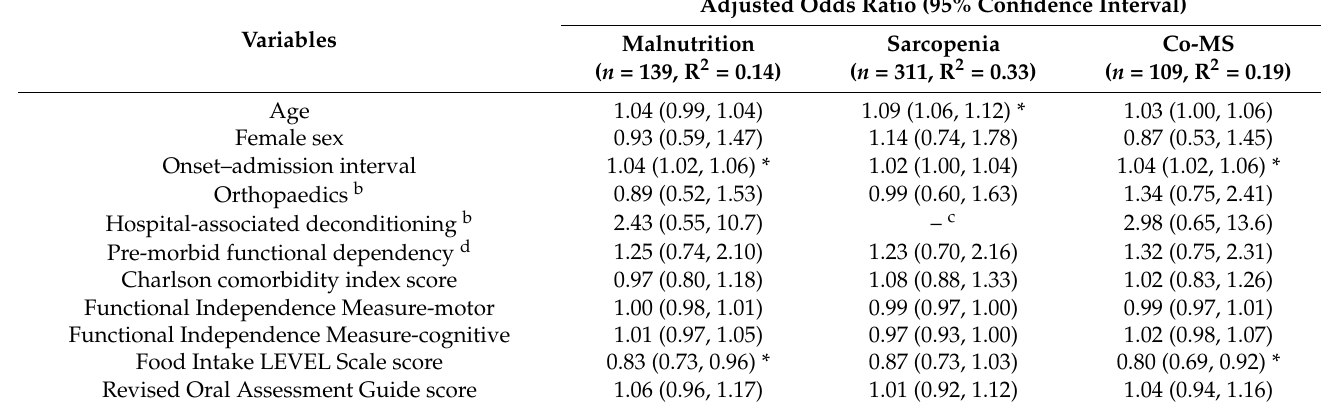
Table 4. Sensitivity analysis of the adjusted odds ratios for malnutrition, sarcopenia, and coexistence of malnutrition